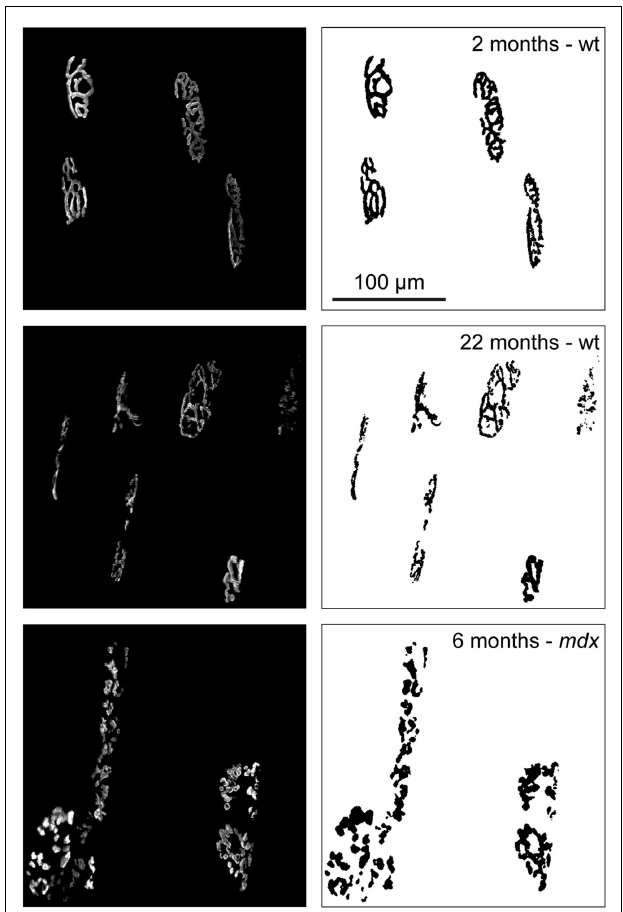
FIGURE 2 |The phenomenon of NMJ fragmentation during aging and dystrophy .Tibialis anterior muscles of wildtype (wt) or dystrophic mdx mice were injected with fluorescently labeled α -bungarotoxin to mark AChRs at the indicated ages and then imaged using in vivo confocal microscopy. Images show maximum intensity projections of several NMJs (left) and binarized pictures (right) to highlight the observation that in young wt AChRs form contiguous, “pretzel-like,” bands while they align in fragmented clusters in aged wt and middle aged dystrophic